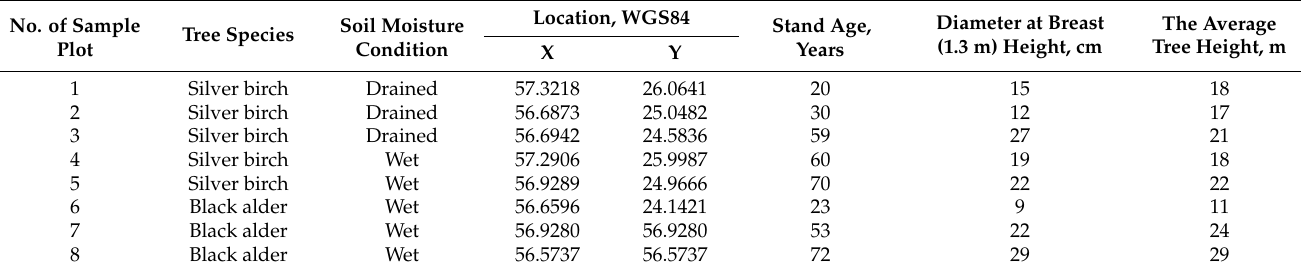
Figure 1. Location of forest stands and sample plots. Forest stand identifiers are shown as numbers. Two sample plots are located in the same stand (Ma—black alder and B—silver birch). Each tree species was represented by at least one mature stand, one middle-aged stand and one young stand. In each sample plot three trees were selected, representing the largest, middle-sized and the smallest trees of the stand. Characteristics of the forest stands are shown in Table 1 and characteristics of individual trees are shown in Table 2. Table 1. Characteristics of the studied forest stands.